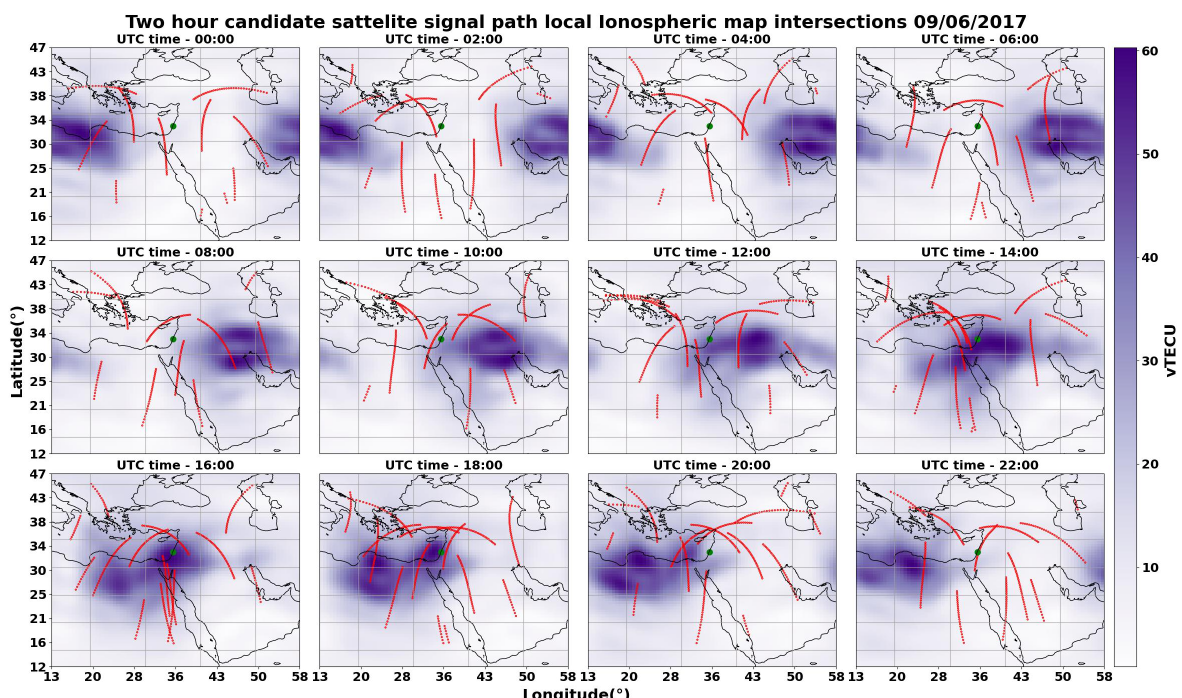
Figure 10. IPP plot. Each grid cell of the LIM represent 2.5 by 5 degree vTEC map resolution, where the red dots indicate the intersection locations of the signal with the ionosphere during a 2-h period. The receiver location is marked in green. Table 4. Statistics for vTEC LIM RMSE over all time candidates and case studies, sorted by different solar activity